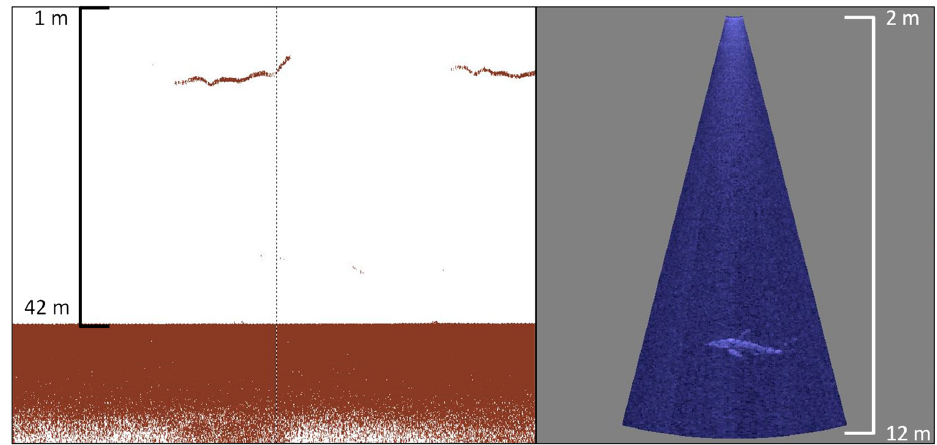
Figure 4. Simultaneous views of a shark collected with the Simrad single beam echosounder and the DIDSON acoustic camera. Simrad TS data are shown in the echogram on the left, which has a − 30 dB re 1 m 2 threshold applied. A DIDSON data frame is on right, has no threshold applied, and corresponds in time to vertical dashed line in the Simrad echogram. Time on the Simrad single beam echosounder is from left to right. Time on the DIDSON is frame by frame like a video. See supplementary file for video.